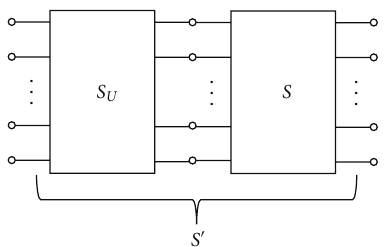
Figure 3: A transformation network placed on the terminal side of the array produces the mode excitations. For example, a wave incident upon a port on the left side of S U produces the corresponding set of modal incident waves at the antenna terminals. This transformation network diagonalizes the antenna S parameter submatrices S 21 and S 12